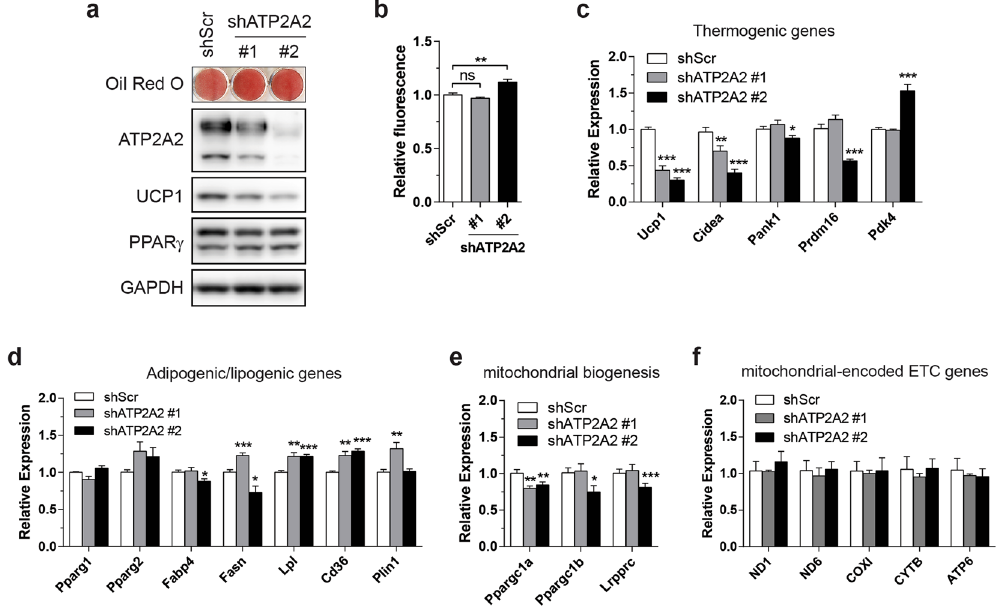
Figure 6. Increasing cytosolic Ca 2 + is sufficient to attenuate thermogenic gene expression. ( a ) Oil red O staining of immortalized primary brown adipocytes stably transduced with ATP2A2 shRNA and immunoblot of ATP2A2, UCP1, PPAR γ and GAPDH (loading control). ( b ) Measurement of cytosolic Ca 2 + in immortalized brown adipocytes stably expressing shATP2A2. ( c–f ) mRNA levels of thermogenic genes ( c ), adipogenic/ lipogenic genes ( d ), mitochondrial biogenesis genes ( e ) and mitochondrial-encoded ETC genes ( f ). Data are mean ± SEM. * P < 0.05, ** P < 0.01, *** P < 0.001, two-tailed unpaired Student’s t- test ( b – f